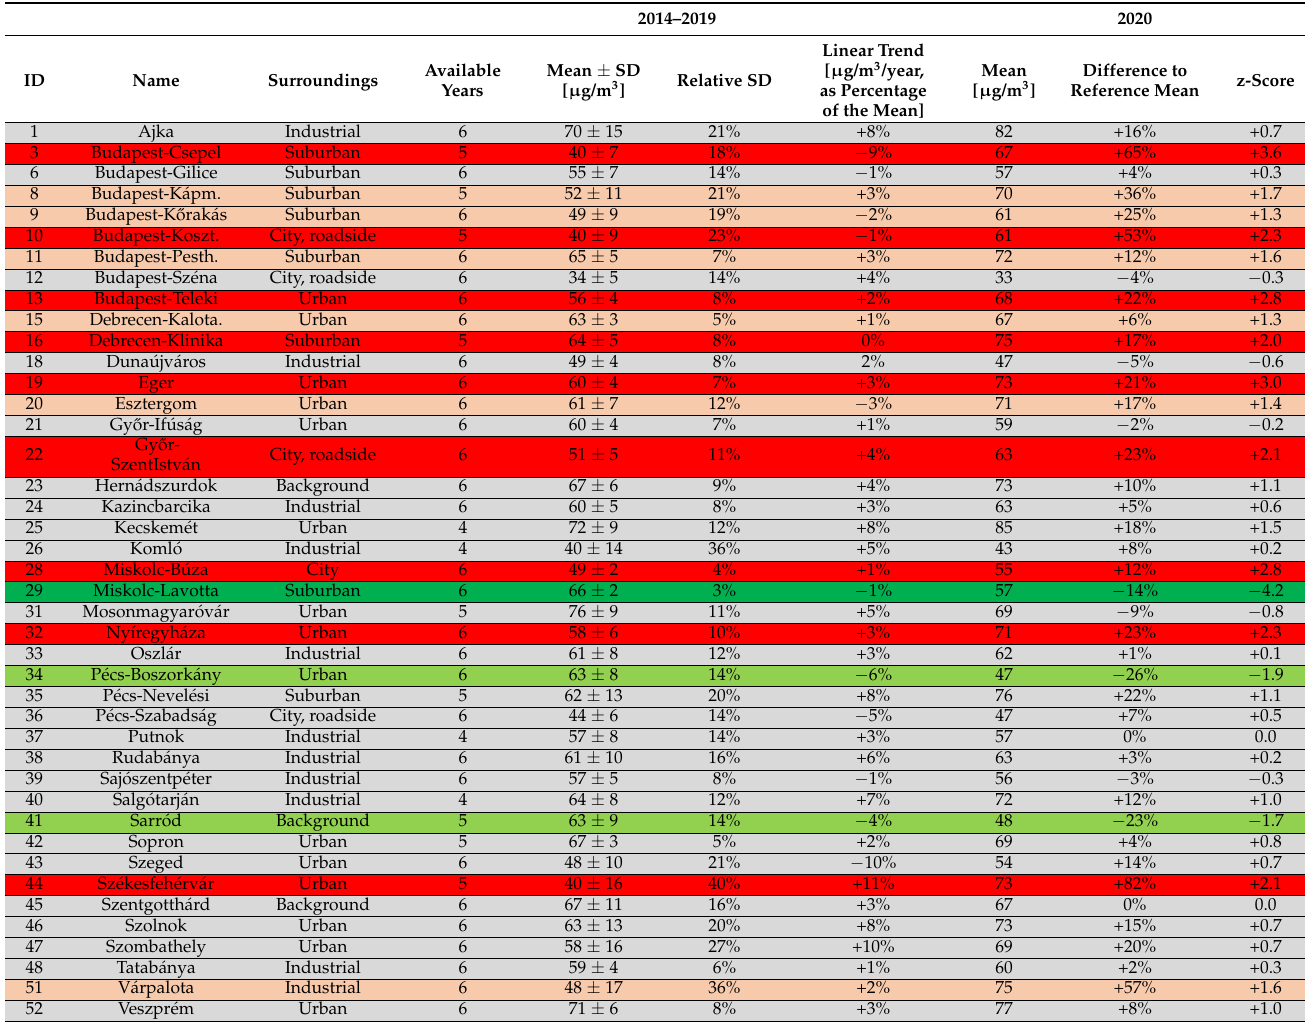
Table A3. Descriptive statistics and changes of O 3 concentrations measured at Hungarian monitoring sites. Row colors: (light) red—z-score at least +1.96 (+0.67) and the difference to the reference mean is more than 3 year’s linear trend. (light) green—z-score less than − 1.96 ( − 0.67), and the difference to the reference mean is more than 3 year’s linear trend. Gray: absolute value of z-score less than 0.67 OR the difference to the reference mean is less than 3 year’s linear trend.